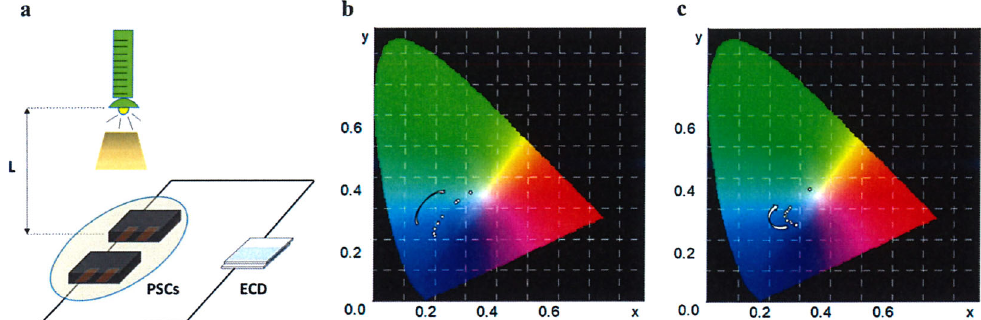
Fig. 6 Colorimetric tests of PSC-powered ECDs under different light intensities. a Schematic diagram for colorimetric test of ECD; colorimetric diagrams of DPV ( b ) and MPV ( c ) based PSC-powered ECDs with descending light